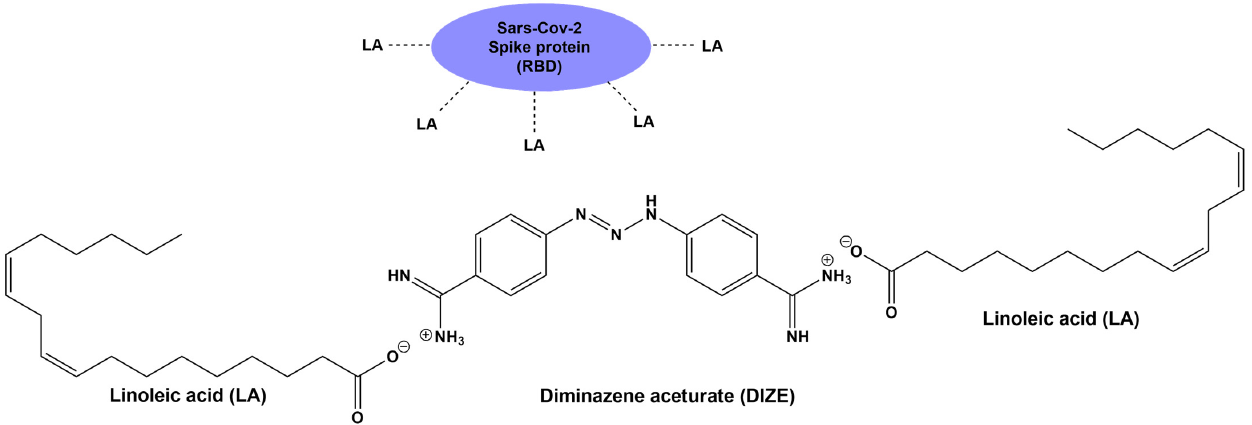
Figure 9. An interaction between DIZE and the linoleic acid of RBD of SARS-CoV-2 is a treatment target. The interaction of linoleic acid (carboxylate negatively charged) with DIZE (carboxymidine positively charged) could destabilize the SARS-CoV-2 spike protein. This implies that ACE2 could not bind to SARS-CoV-2 and could retain its molecular integrity, keeping its ability to degrade toxic AngII.